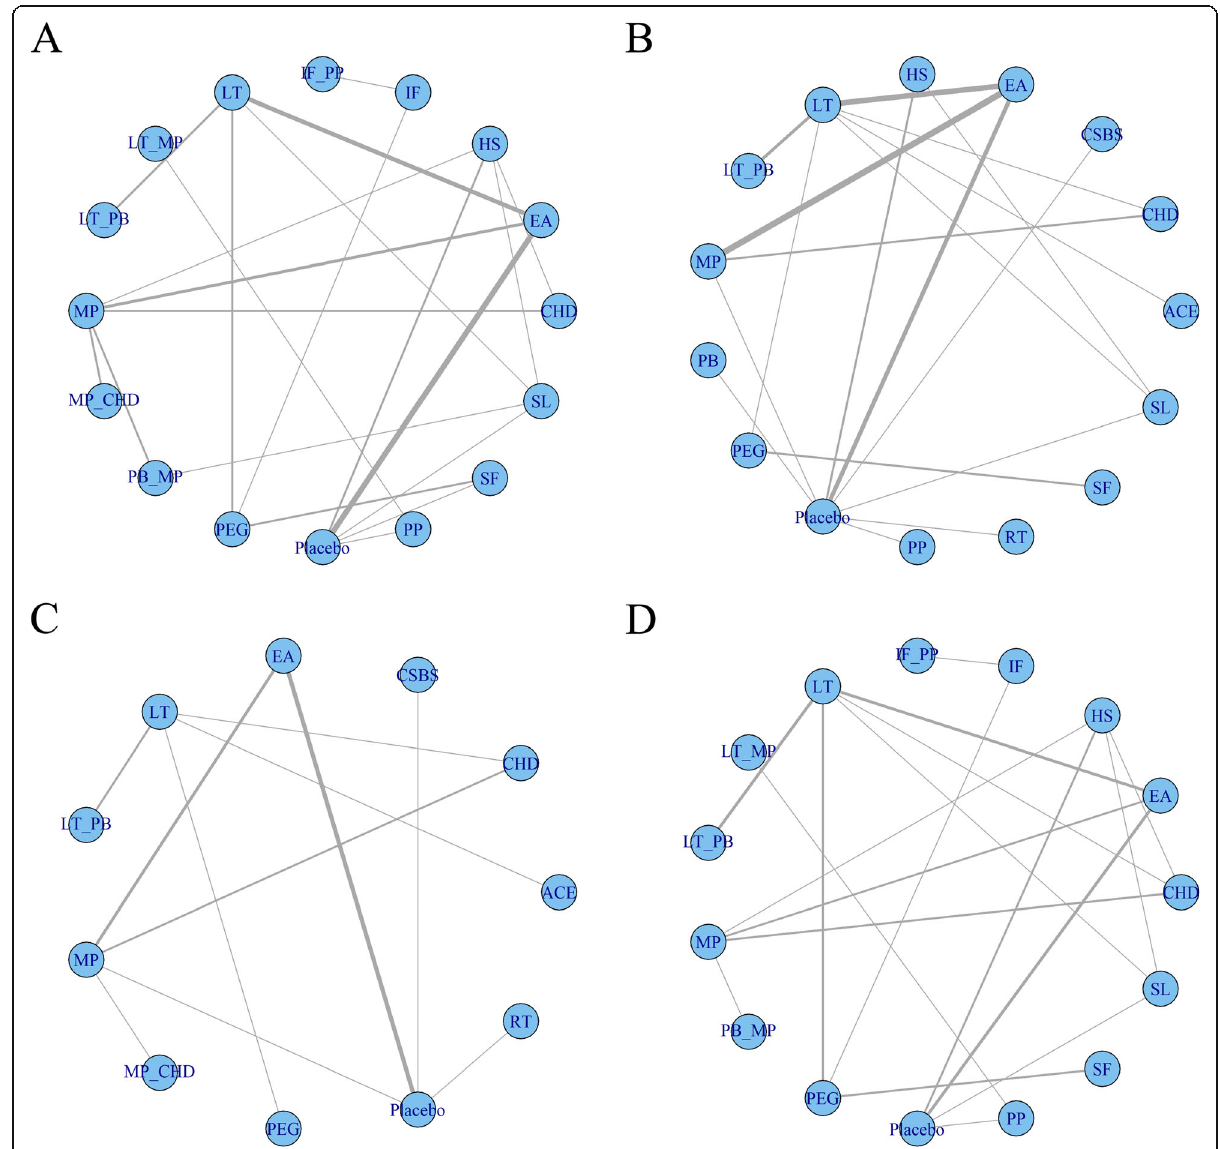
Fig. 3 Network plot. a Network plot of the primary outcome. The primary outcome is the responder rate, based on ≥ 3 SBMs/week after treatment. b Network plot of the SBM count. c : Network plot of the BS. d : Network plot of adverse